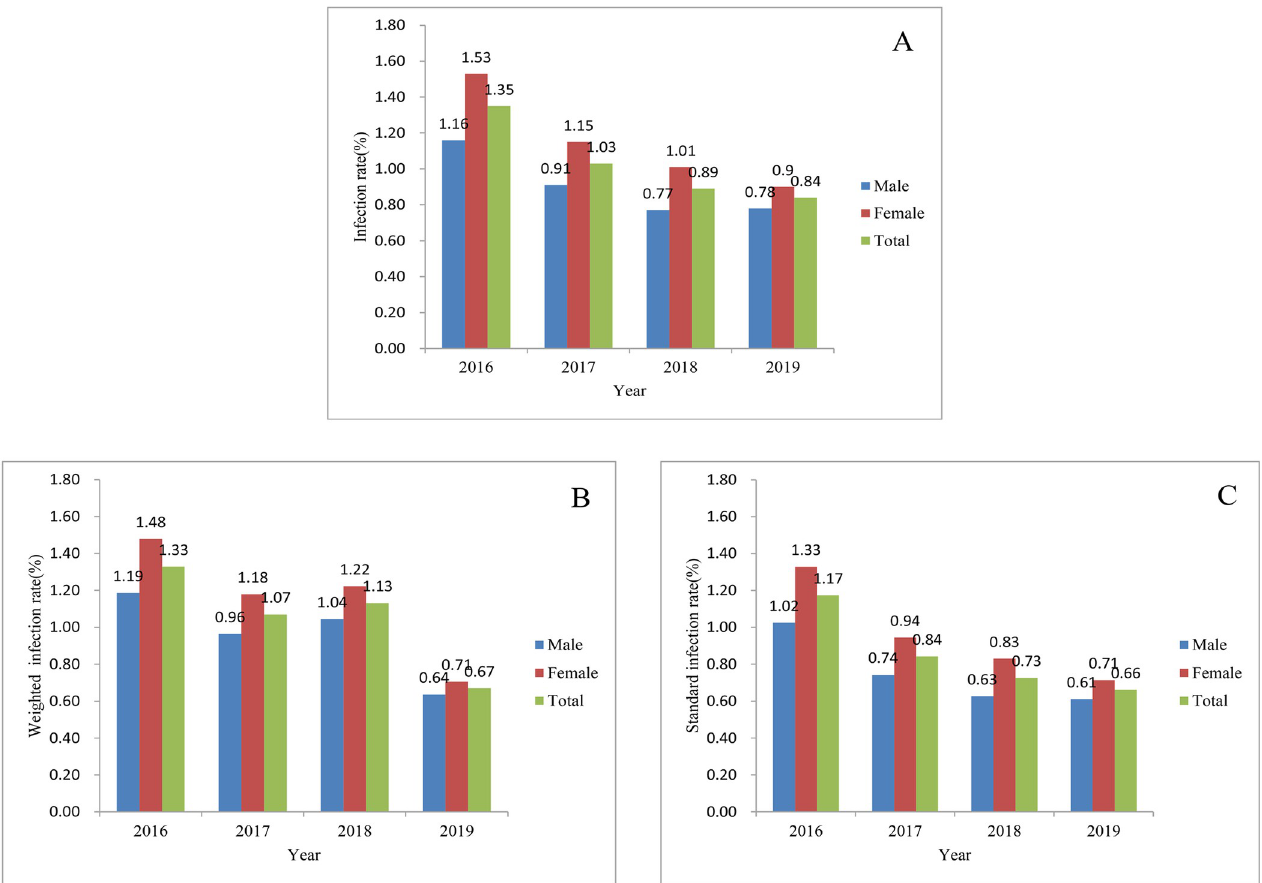
Fig 4. Gender distribution of hookworm infections from 2016 to 2019 according to the national surveillance. A. Infection rate; B. Weighted infection rate; C. Standard infection rate.